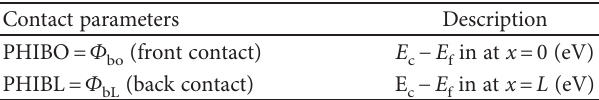
Table 1: Boundary conditions of the front and back contacts of